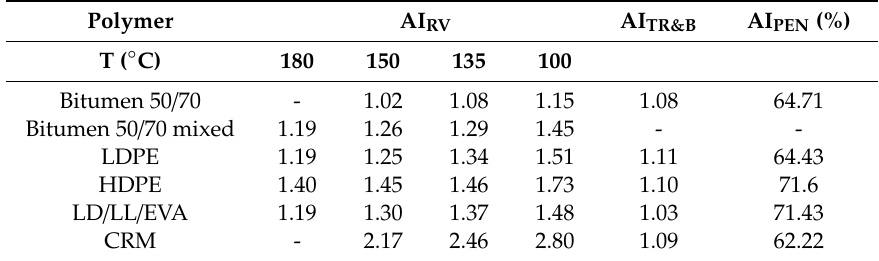
Table 10. Aging indices for rotational viscosity, penetration, and ring and ball temperature. Polymer AI RV AI TR&B AI PEN (%) T ( ◦